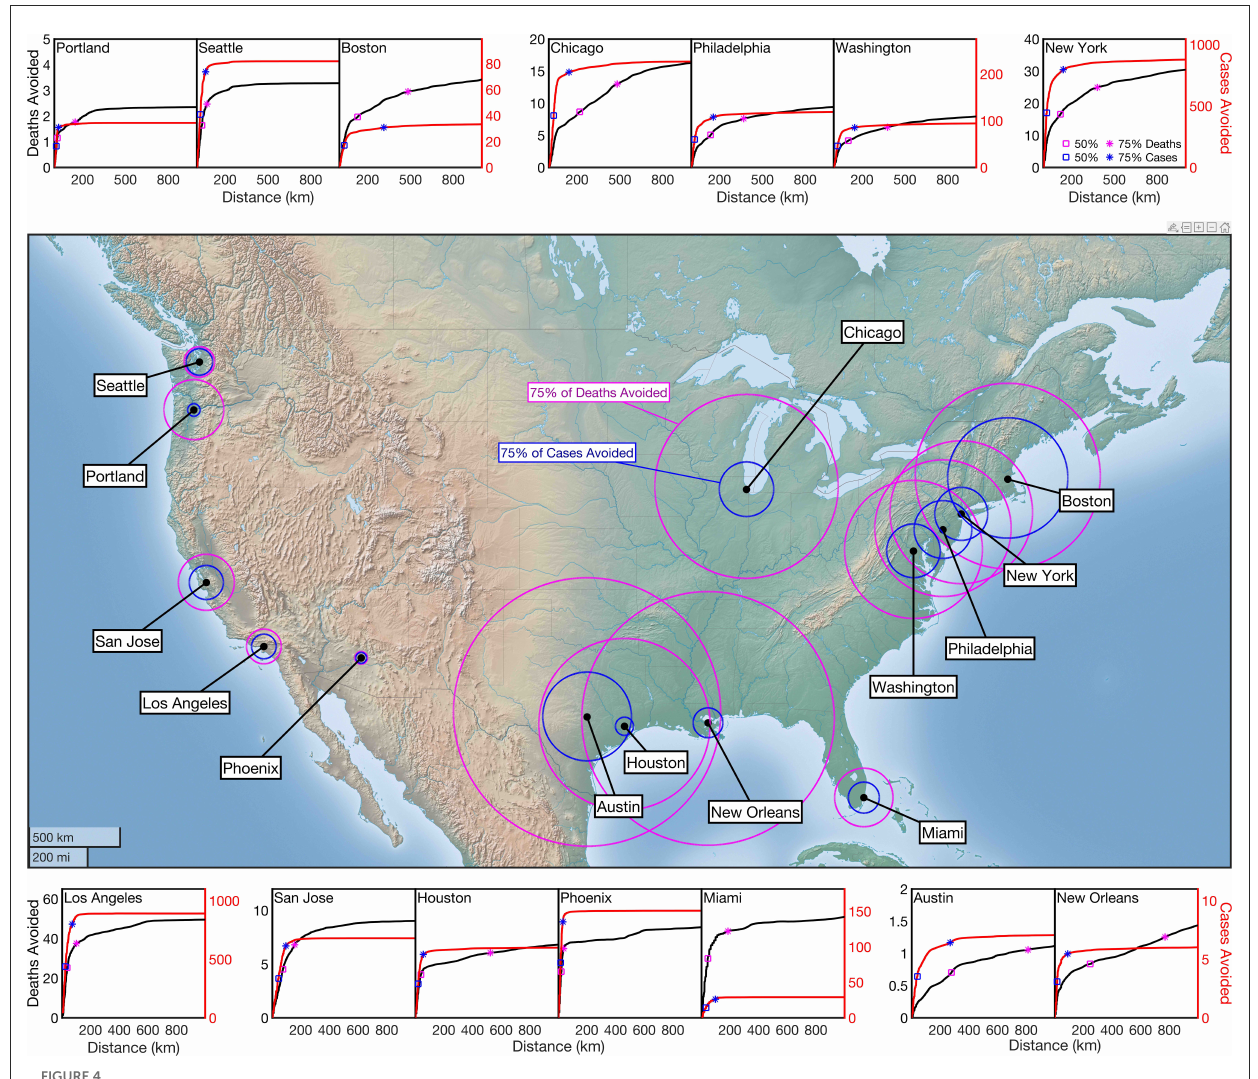
FIGURE4 Cumulative PM 2.5 - and O 3 -related premature deaths (black) and NO 2 -related new asthma cases (red) avoided in 2040 from a proposed vehicle miles traveled fee. On the cumulative distribution plots, the distance at which 50% (square) and 75% (asterisk) are marked for both premature deaths (magenta) and new asthma cases (blue). On the map, the distances at which 75% of premature deaths (magenta) and 75% of new asthma cases (blue) are